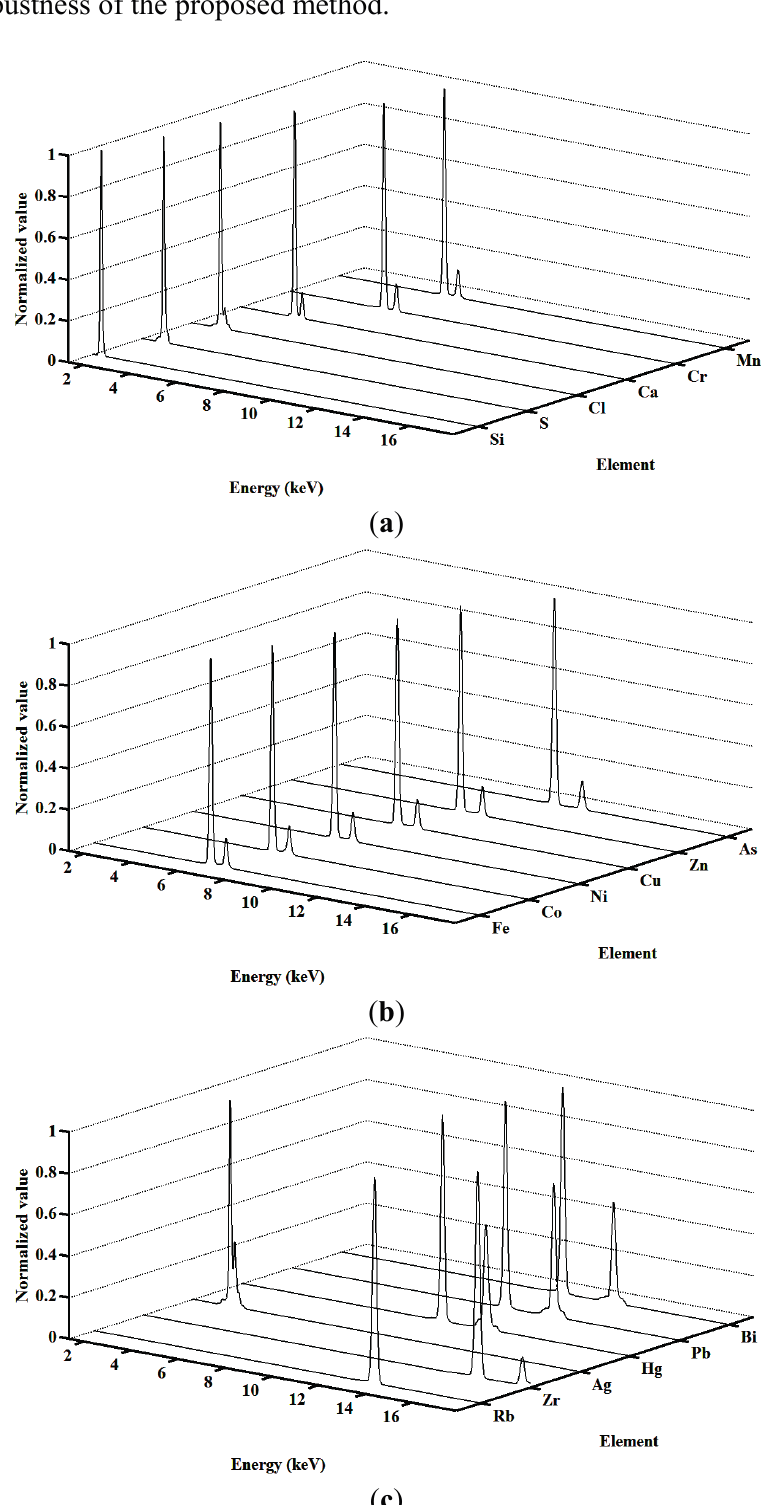
Figure 5. Normalized characteristic curves in the spectral decomposition framework. ( a ) Normalized characteristic curves of Si, S, Cl, Ca, Cr and Mn; ( b ) Normalized characteristic curves of Fe, Co, Ni, Cu, Zn and As; ( c ) Normalized characteristic curves of Rb, Zr, Ag, Hg, Pb and